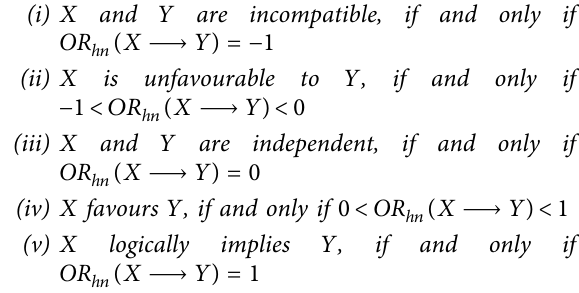
GK and OR in the